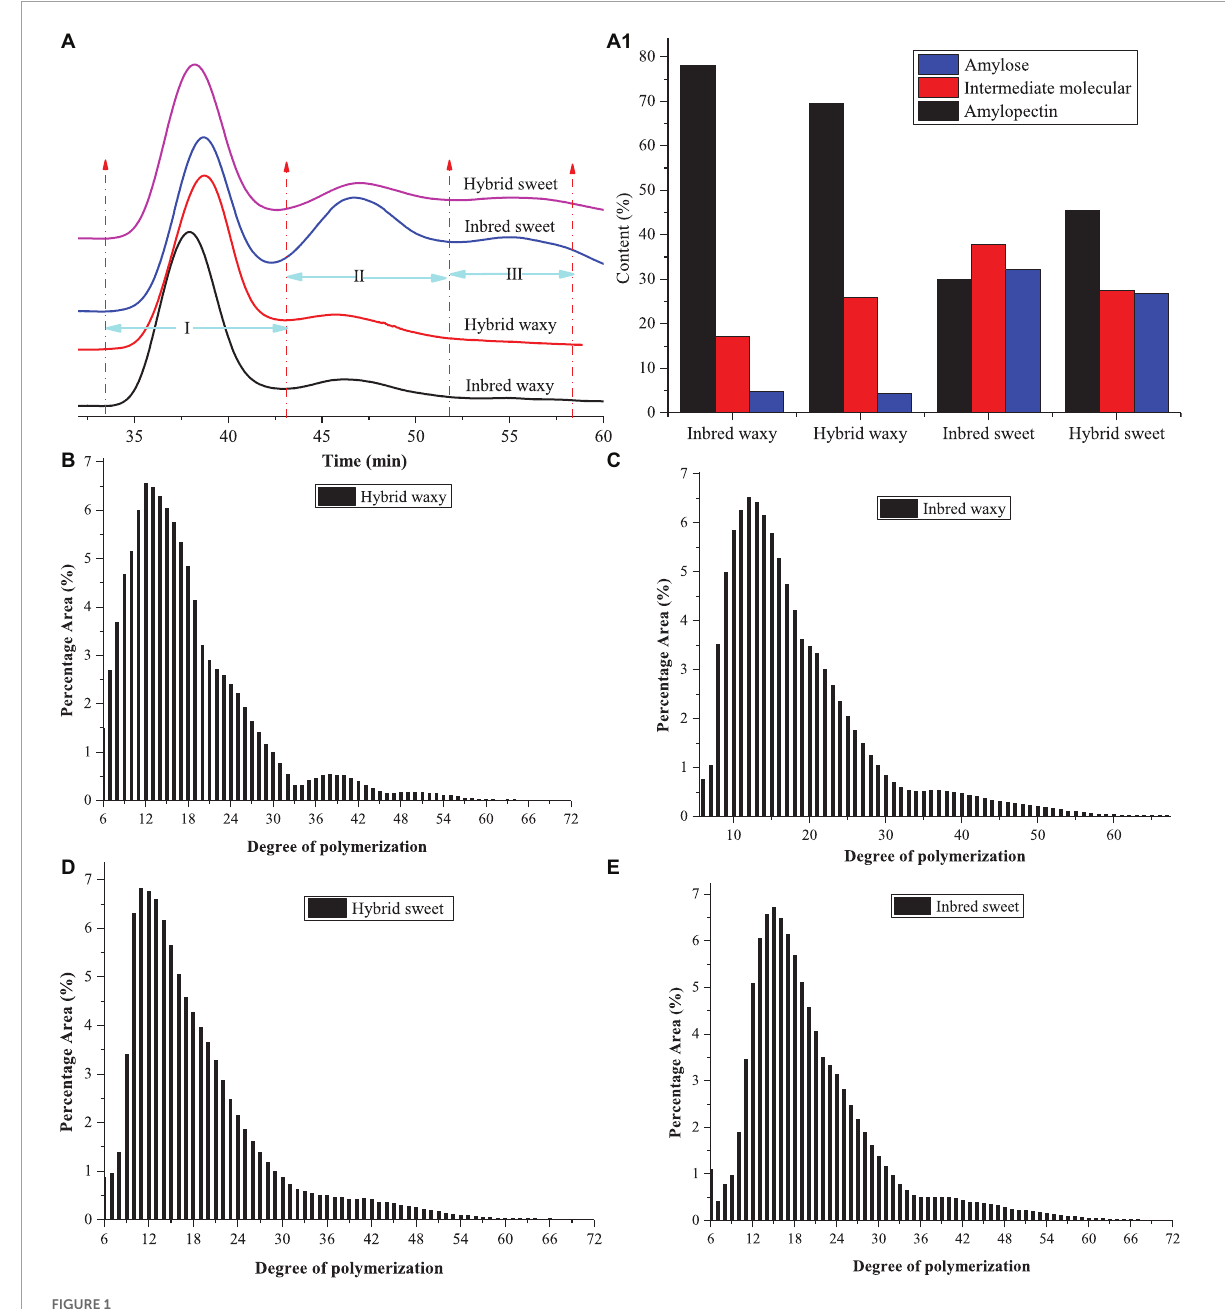
FIGURE1 Molecular weight and chain length distribution of starch from waxy, sweet, and hybrid sorghum. (A,A1) Molecular weight distribution; (B–E) chain length distribution.